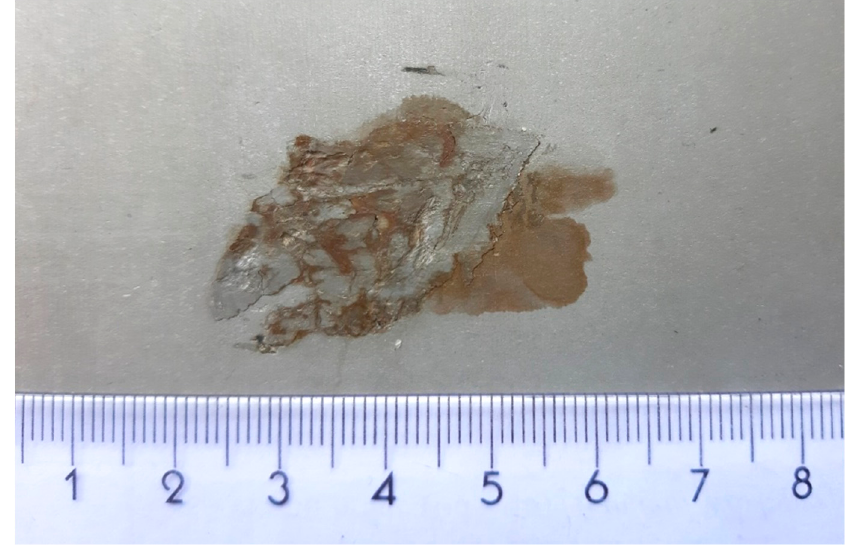
Figure 7. Foreign material inside strip (cm).